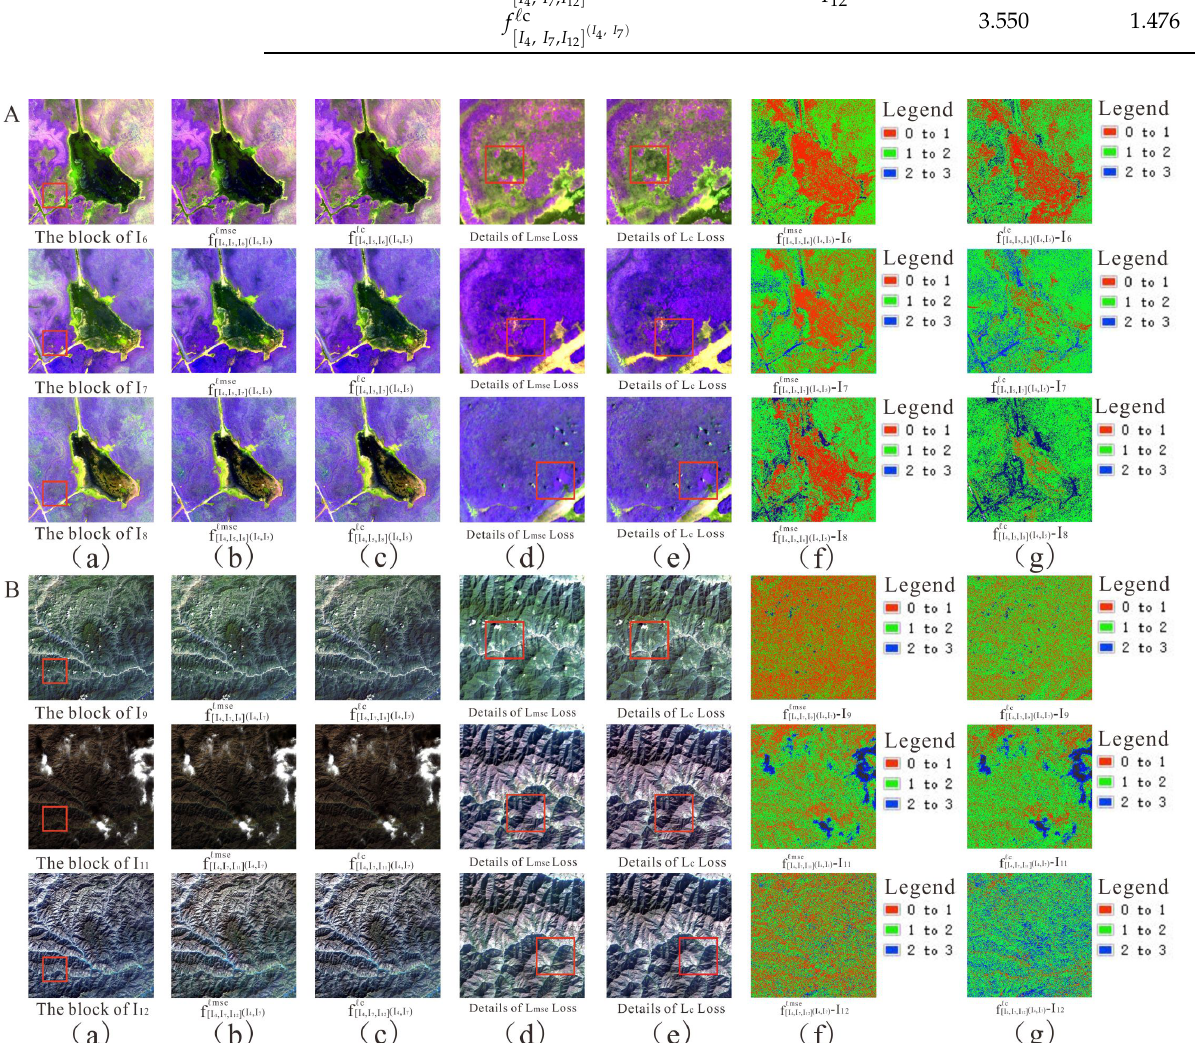
Figure 7. Visual effect, detailed information, and pixel error between block interpolated result and reference block using ( A ) UAV and ( B ) Landsat-8 datasets with ( a ) initial image ( b , d , f ) (cid:96) mse loss and ( c , e , g ) (cid:96) c